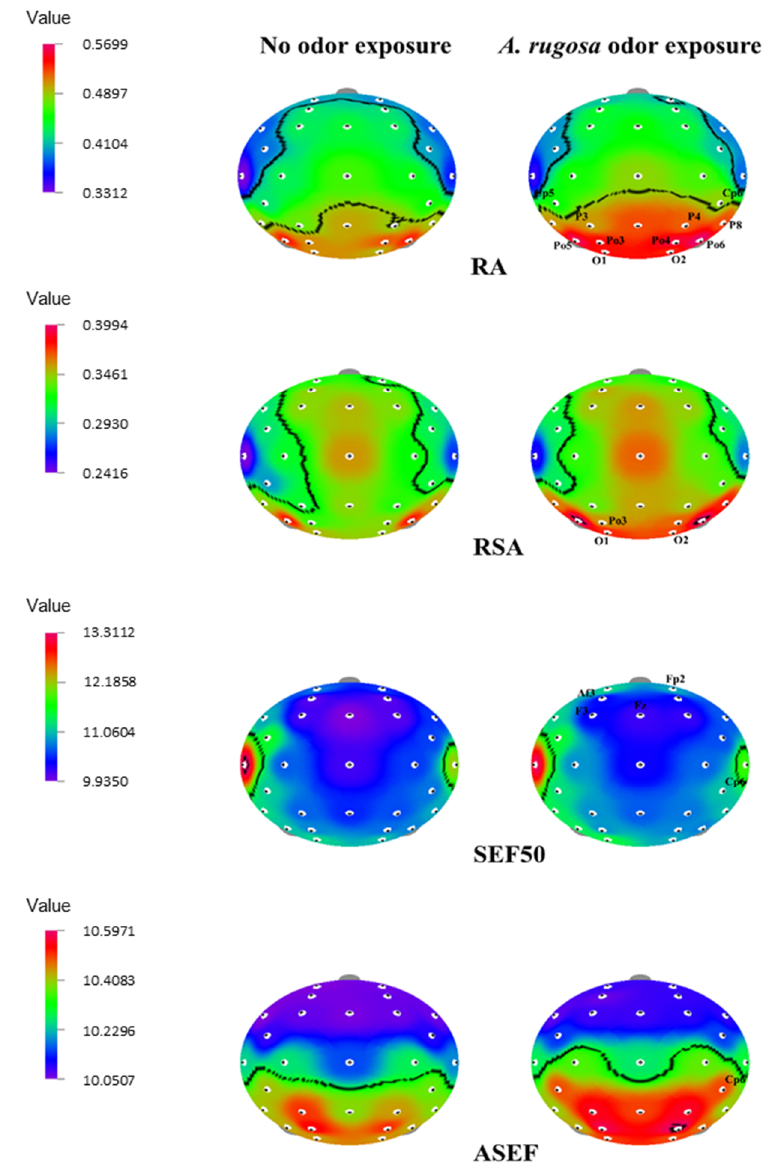
Figure 3. The t-mapping of EEG power spectrum changes during no odor and A. rugosa essential oil odor conditions. ASEF, spectral edge frequency 50% of alpha; RA, relative alpha; RSA, relative slow alpha; SEF50, spectral edge frequency 50%. The marked sites in the t-mapping denote the significant changes during exposure to A. rugosa essential oil.